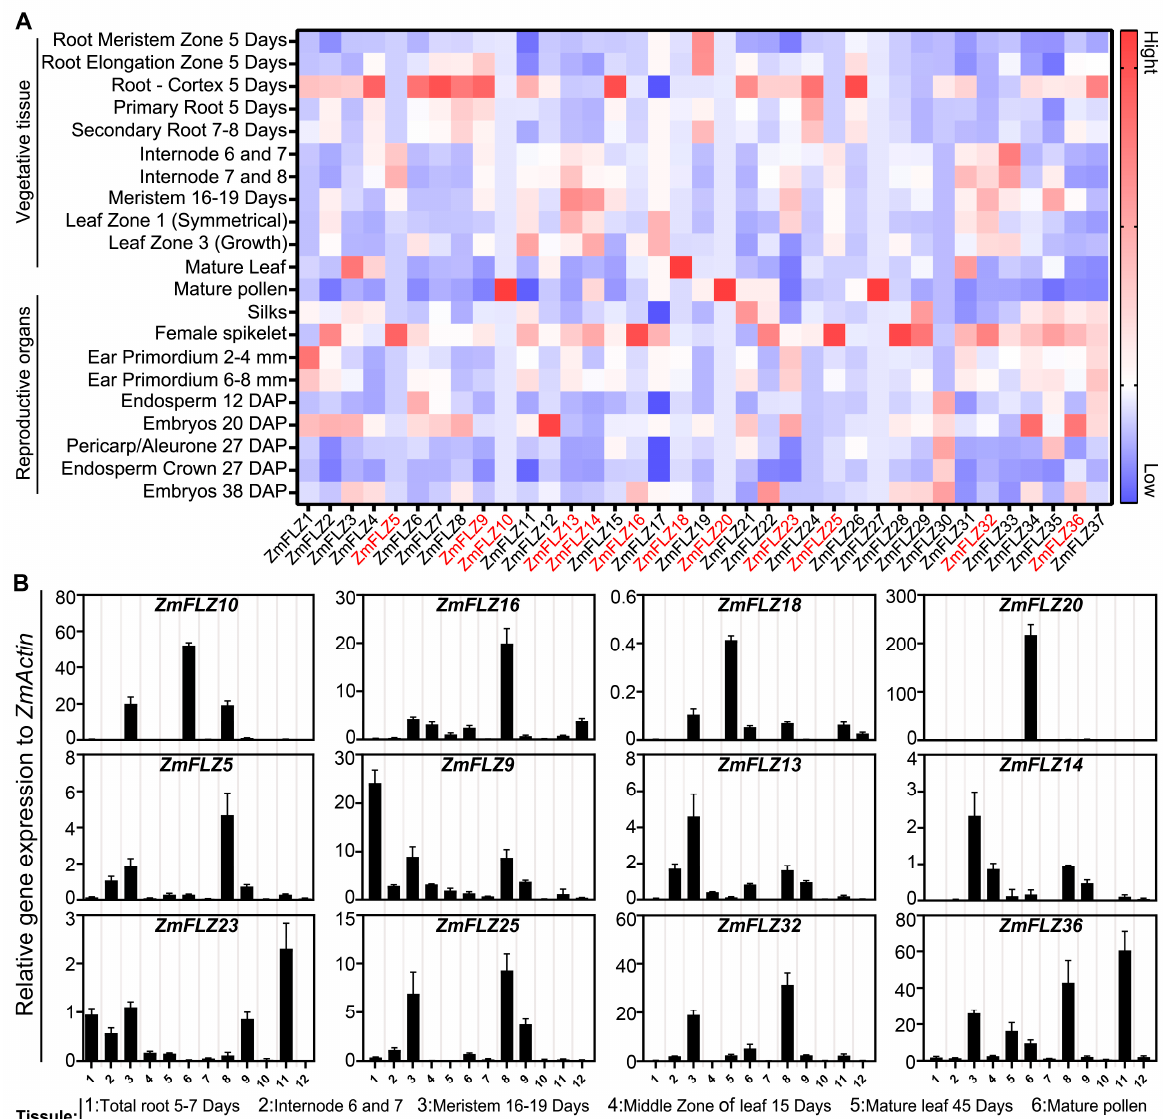
Figure 2. Spatial expression patterns of ZmFLZs . ( A ) Heat map of the gene expression of ZmFLZs in various tissues or developmental stages. The data were downloaded from the qTeller of MaizeGDB (https://qteller.maizegdb.org/; accessed on 1 September 2019). The expression levels as indicated by Fragments Per Kilobase of exon model per Million mapped fragments (FPKM) were shown from low (blue) to high (red) for each gene. ( B ) Tissue-specific expression patterns of ZmFLZs by qRT-PCR assay. The x -axis represents different tissues or organs. The y -axis shows the relative gene expression levels normalized to ZmActin . Data represent the mean ± SEM from three independent experiments. DAP, day after pollination.